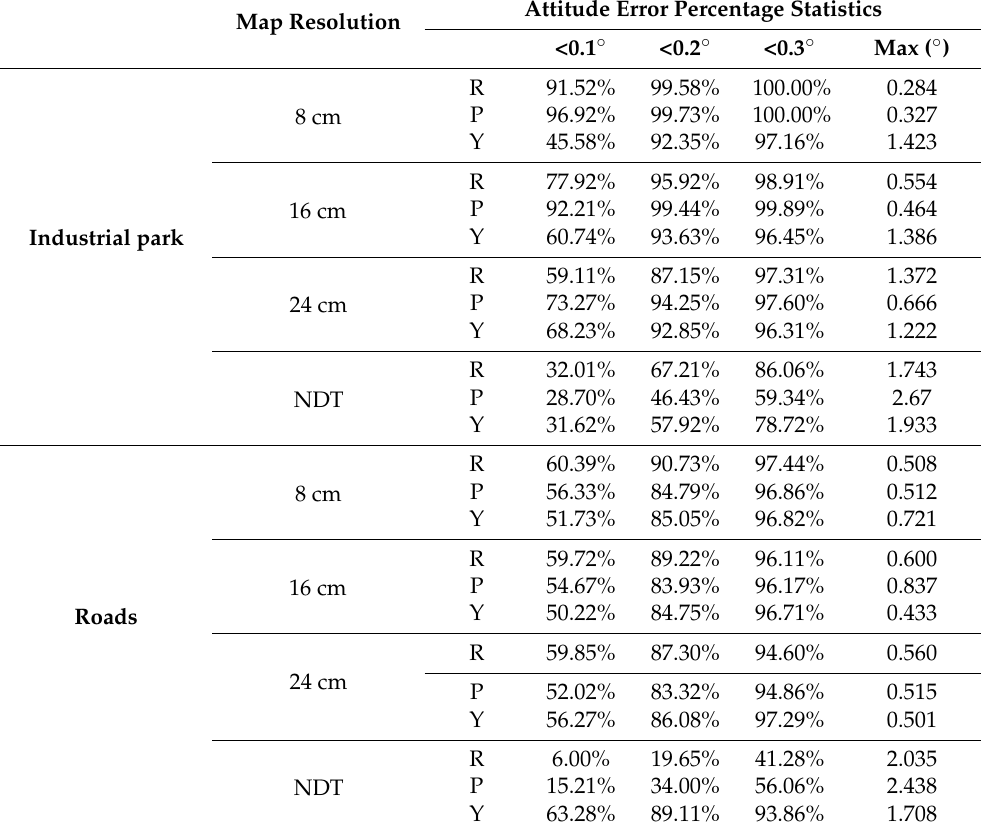
Table 6. Quantitative analysis: the percentage of attitude results better than 0.1 ◦ , 0.2 ◦ , 0.3 ◦ , and max attitude errors.